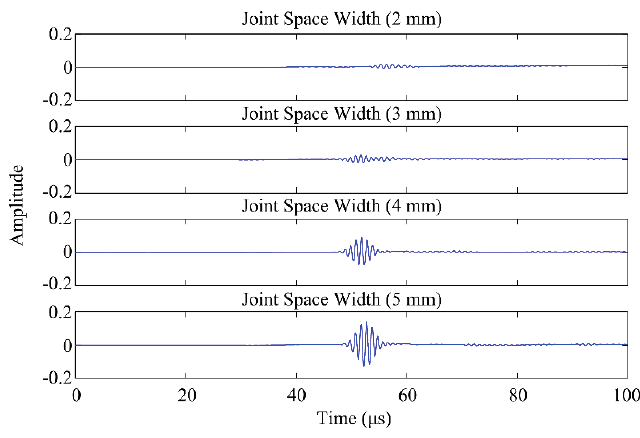
Figure 6. Outputs of the parametric models simulating the joint space width.